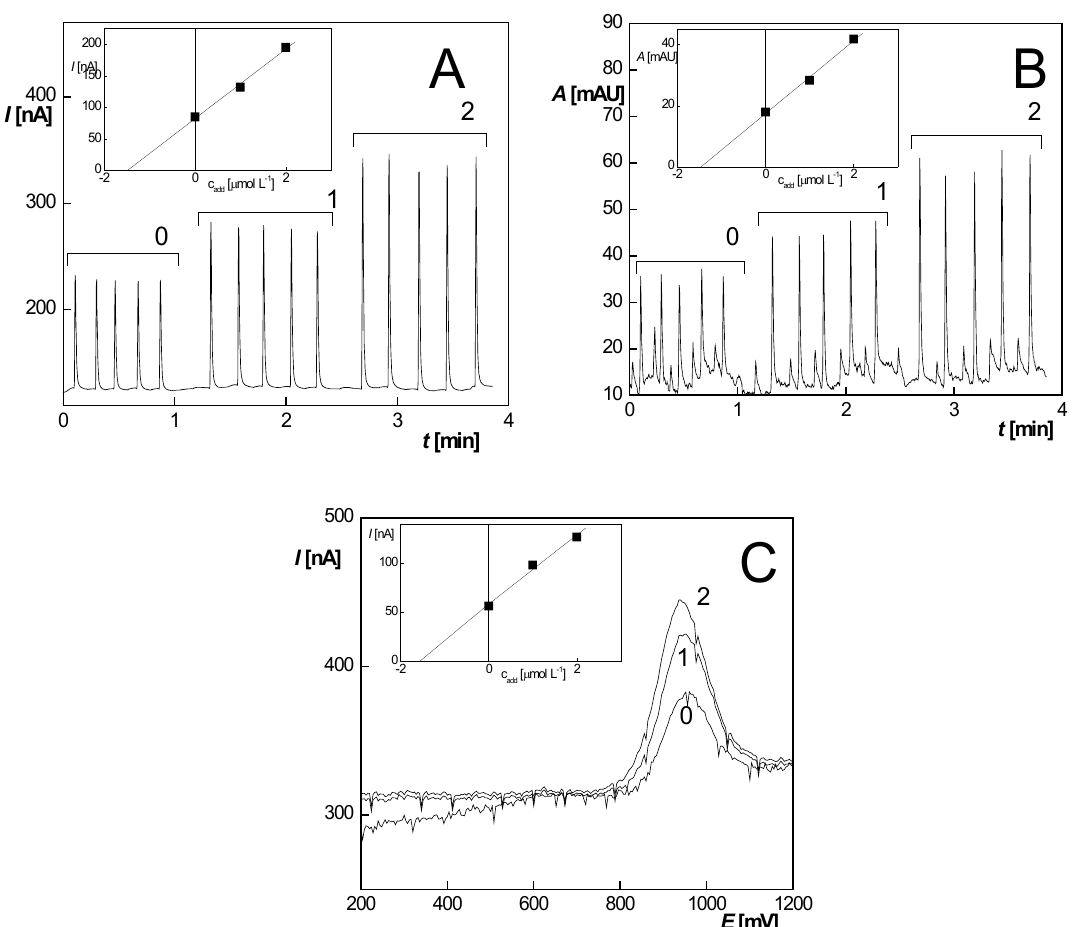
Figure 5. Records of the determination of metoclopramide in Cerucal tablets using standard addition method, obtained by FIA with amperometric detection (A), FIA with spectrophotometric detection (B) and DPV (C); number of additions shown above the curves, insets show the corresponding concentration dependences. Medium B-R buffer pH 6, flow rate 5.0 mL min −1 , E λ = 316 nm, injected volume 20 DET